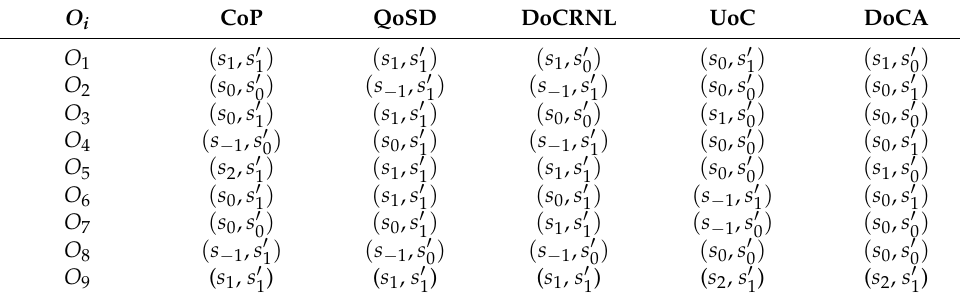
Table 5. Qualitative matrix for criteria evaluation by decision-maker 1 ( Γ 1